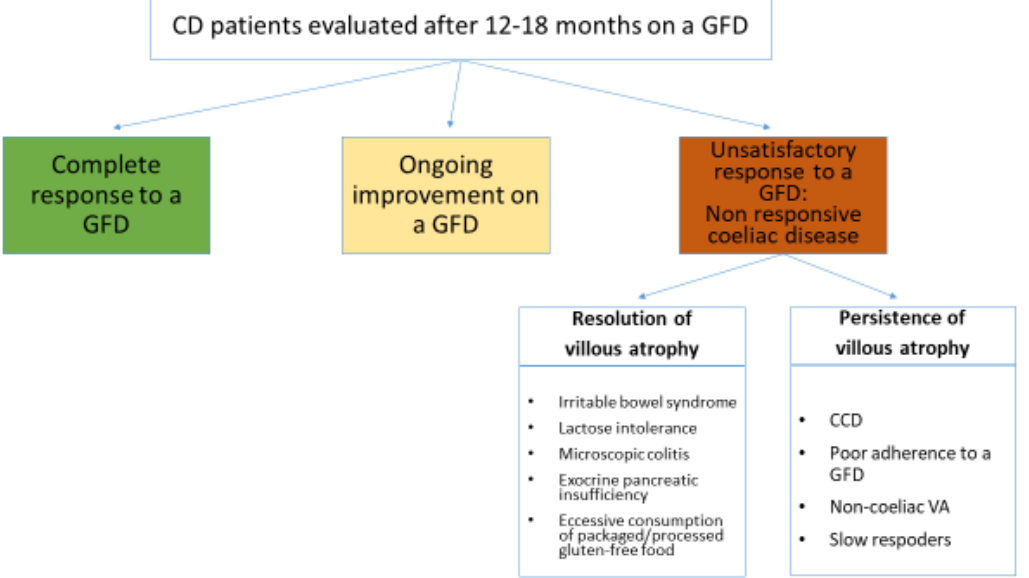
Figure 2. Proposal for a nosographic classification of clinical scenarios responsible for persisting clinical and/or histological abnormalities in coeliac patients on a gluten-free diet for 12–18 months. GFD: gluten-free diet; VA: villous atrophy; CCD: complicated coeliac disease.